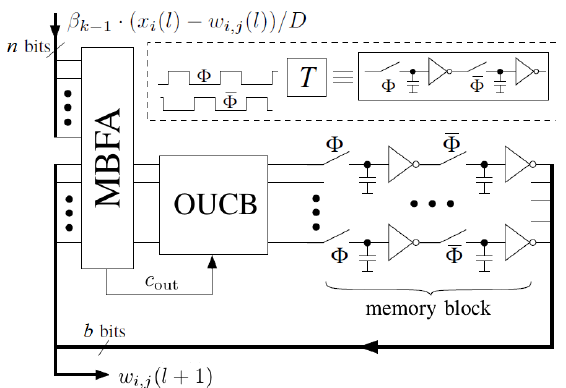
Figure 10. A general idea of the adaptation mechanism that receives weight updates from the circuit shown in Figure 7 (OUCB is an over/underflow control block).